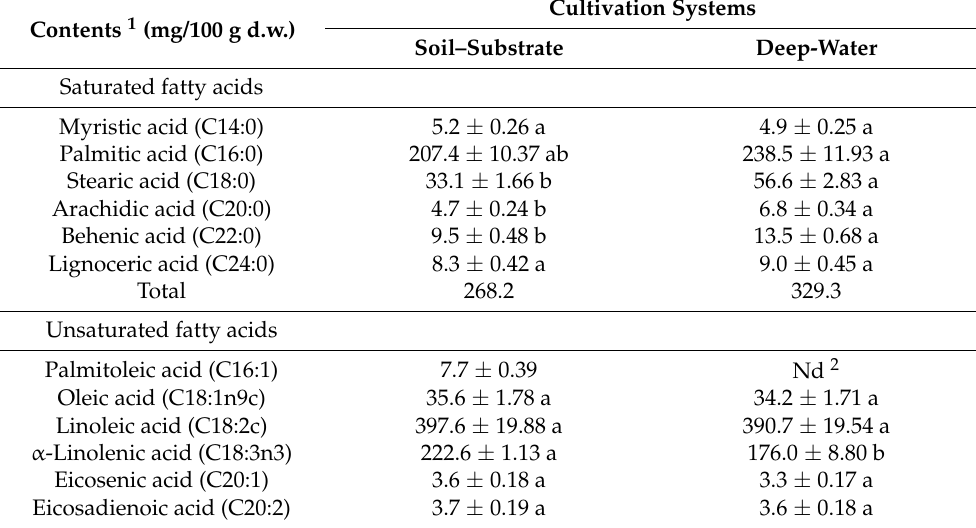
Table 1. Comparison of fatty acid contents of PGS in different cultivation systems in a plant factory. Contents 1 (mg/100 g